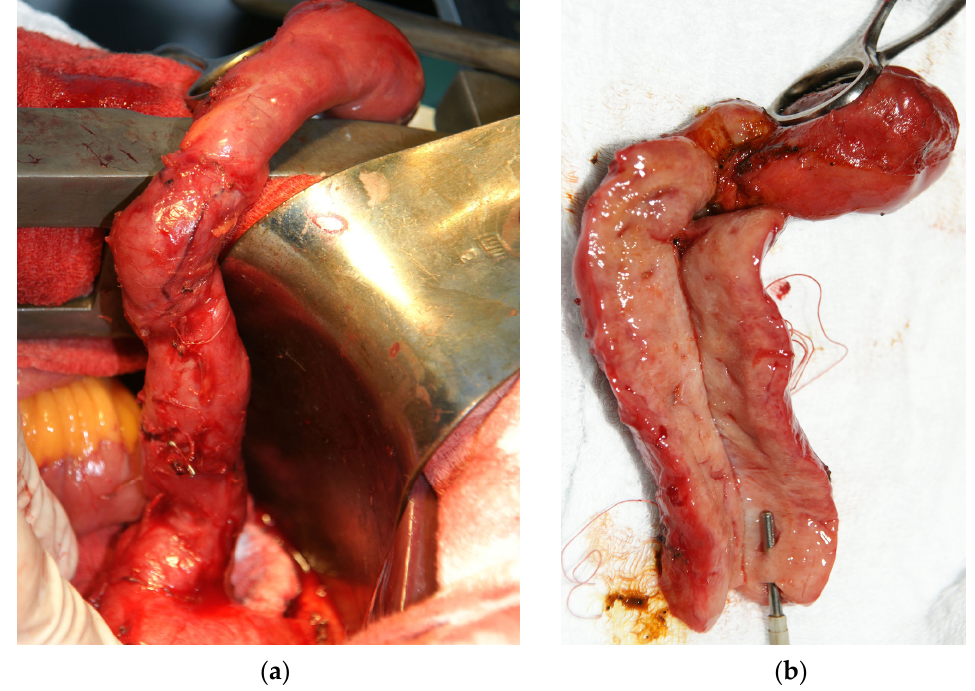
Figure 1. ( a ) Intraoperatively, a long and filiform cystic duct was observed with ( b ) a thick wall noticed on the cut section.